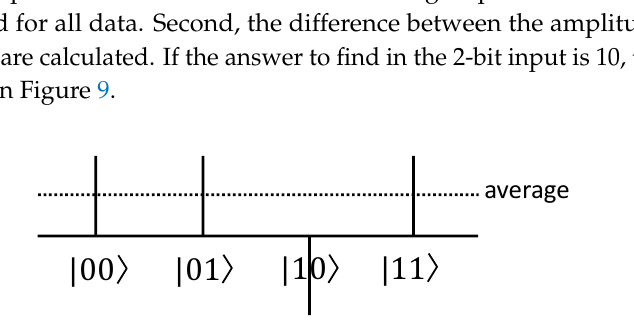
Figure 9. Condition after the oracle of Grover